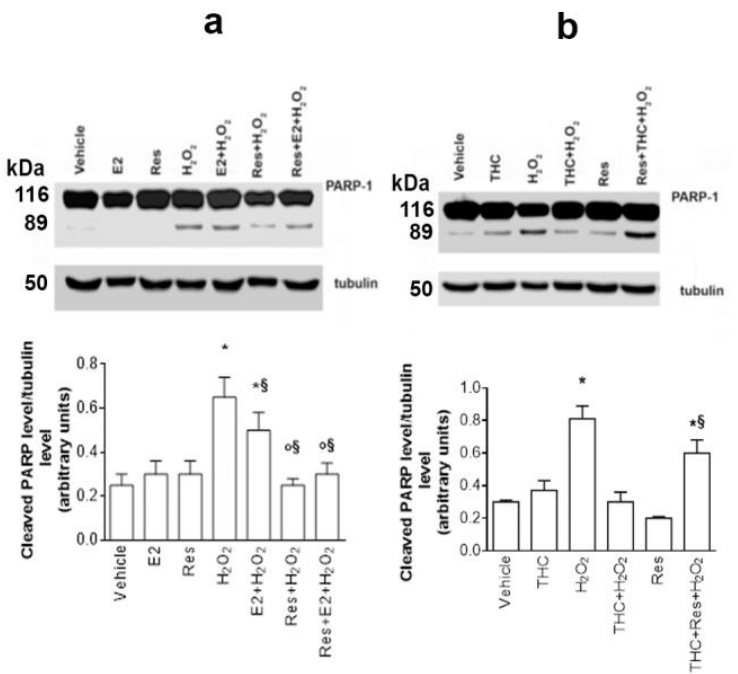
Figure 7. Effect of Res on H 2 O 2 -induced apoptosis in SH-SY5Y cells. ( a ) Analysis by Western blot of PARP-1 cleavage in SH-SY5Y cells treated for 24 h with vehicle (DMSO 1: 1000, v : v ), E2 (10 − 9 M), Res (10 − 7 M), H 2 O 2 (5 × 10 − 5 M), E2 + H 2 O 2, and Res + H 2 O 2 , at the same concentrations. Tubulin protein was used to normalize blot loading. The top panel shows a Western blot type, and the bottom panel shows the densitometric analysis of at least three different experiments. Data are reported as mean ± SD. p < 0.01 was calculated with Student’s t -test with respect to vehicle (*), E2 ( ◦ ), and H 2 O 2 (§). ( b ) Analysis of PARP-1 cleavage in SH-SY5Y cells pretreated with (R,R)-THC (10 − 6 M) 1 h before stimulation with vehicle (DMSO 1: 1000, v : v ), H 2 O 2 (5 × 10 − 5 M), Res (10 − 7 M), (R,R)-THC + H 2 O 2 , Res + THC, and Res + THC + H 2 O 2 at the same concentrations for 24 h. Tubulin protein was used to normalize blot loading. The top panel shows the Western blot type, and the bottom panel